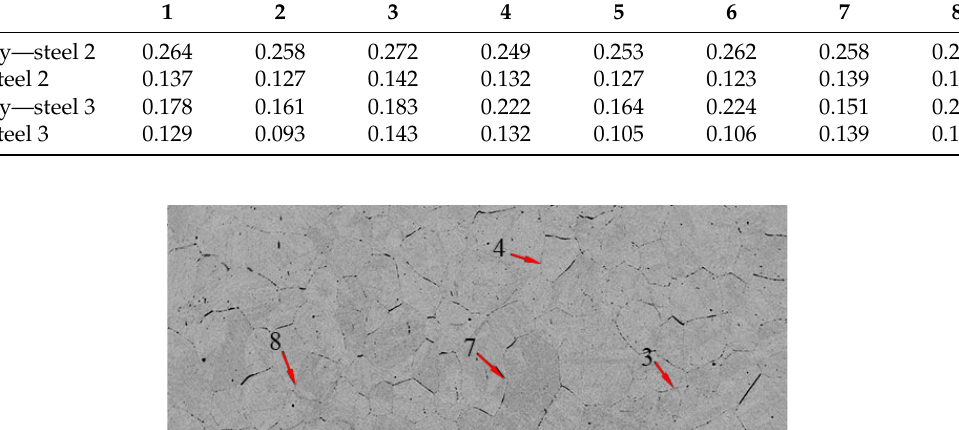
Table 2. Results of quantitative analysis of different samples tested by EPMA (wt.%). Point